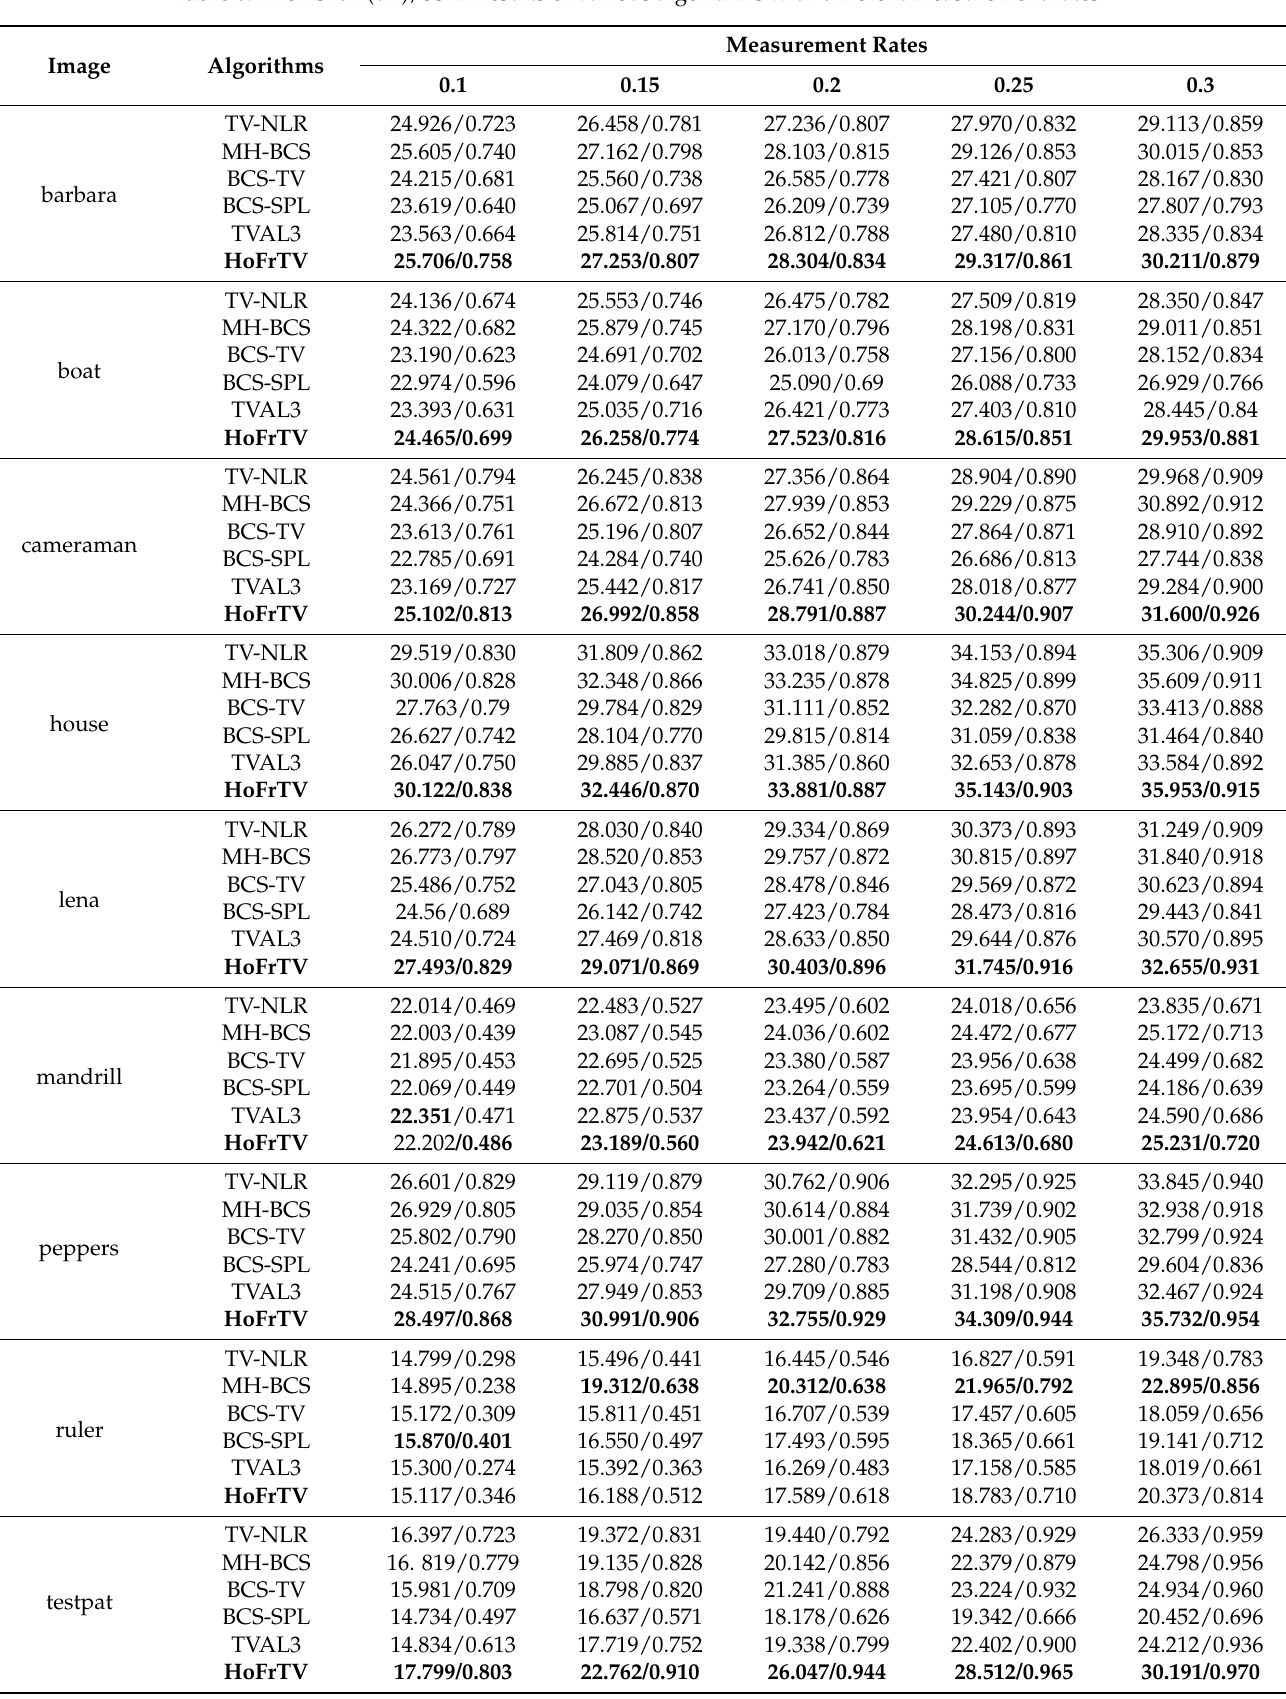
Table 6. The PSNR (dB)/SSIM results of various algorithms with different measurement rates.